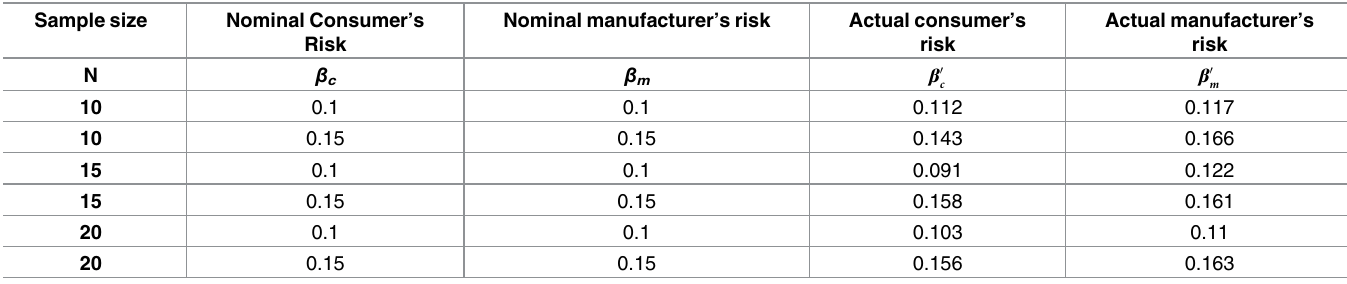
Table 8. Actual test risks under Weibull